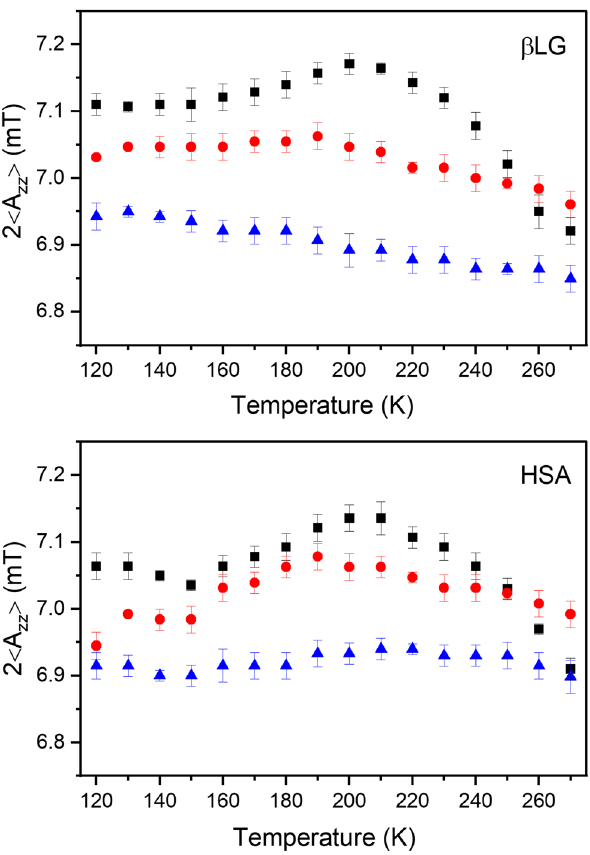
Figure 3: Temperature dependence of the outermost hyper fi ne separation, 2 〈 A zz 〉 , for β LG/5 - MSL and HSA/5 - MSL at di ff ering hydration conditions: lyophilized ( triangles ) , low hydration ( cir - cles ) , and full hydration ( squares )